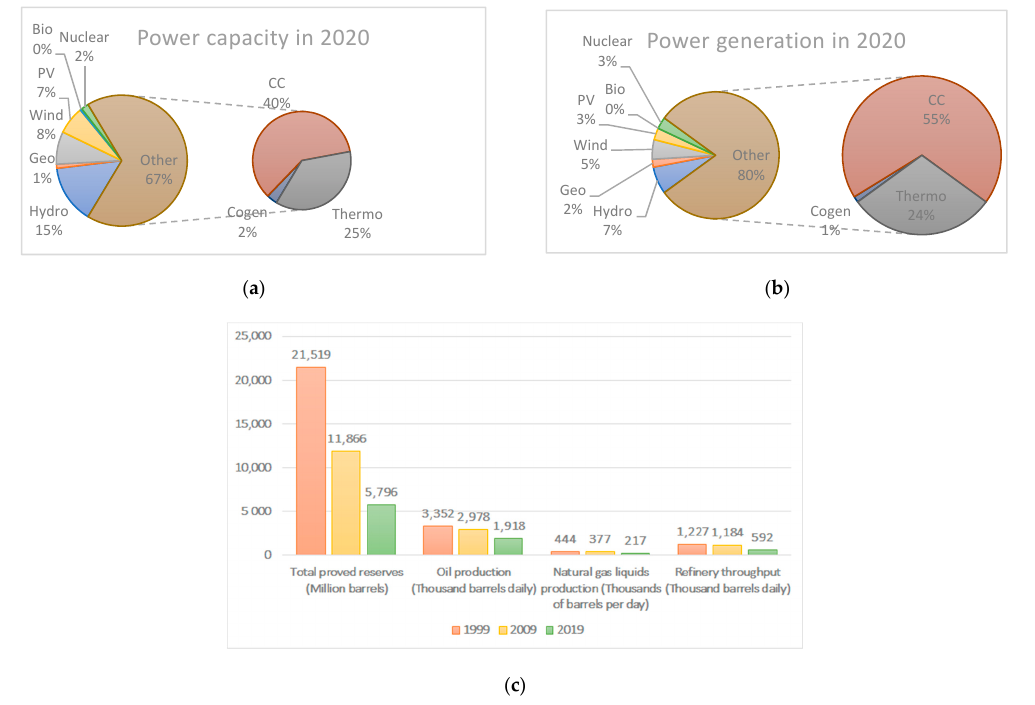
Figure 2. Mexico’s power: ( a ) power capacity in 2020, ( b ) power generation in 2020, ( c ) proven oil reserves, oil production, natural gas liquids production, and refinery throughput, Source: Adapted by the authors using BP data [45].